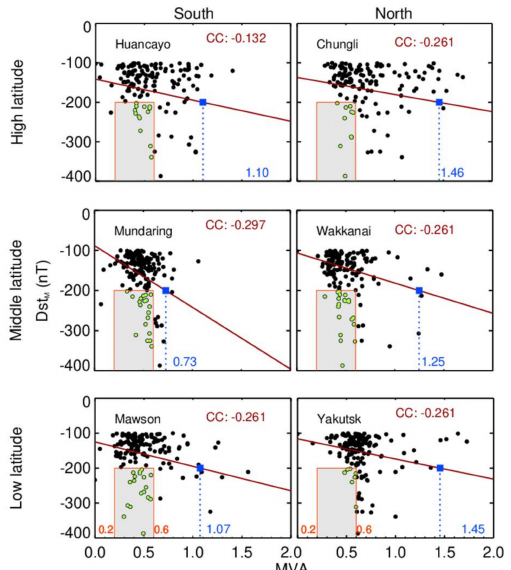
Figure 3. Scatterplots between the minimum of Dst ( Dst M ) and the corresponding max value of | δ foF2 | ( MVA ) during all geomagnetic storm events (Dst < -100 nT), for six selected stations from high to low latitudes in the Northern and Southern hemispheres. The shaded area is the region chosen for weak response events. The blue square is the MVA calculated using the linear fit (red lines) with a Dst of -200 nT. The CC is the Pearson correlation coe ffi cient between Dst M and MVA